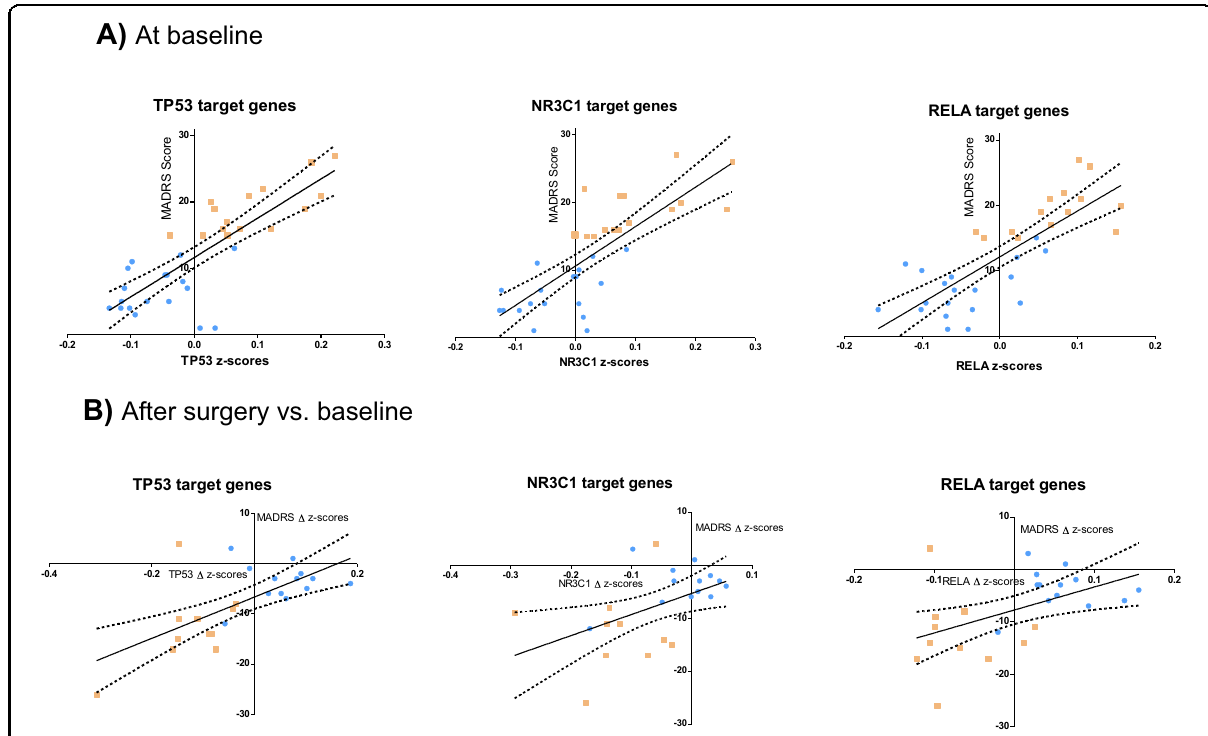
Fig. 4 TP53, NR3C1, and RELA pathways predict the intensity of in fl ammation-related depressive symptoms at baseline ( A ) and their decrease after bariatric surgery ( B ). Multivariate linear regression analyses. MDD patients (orange symbols), non-MDD patients (blue